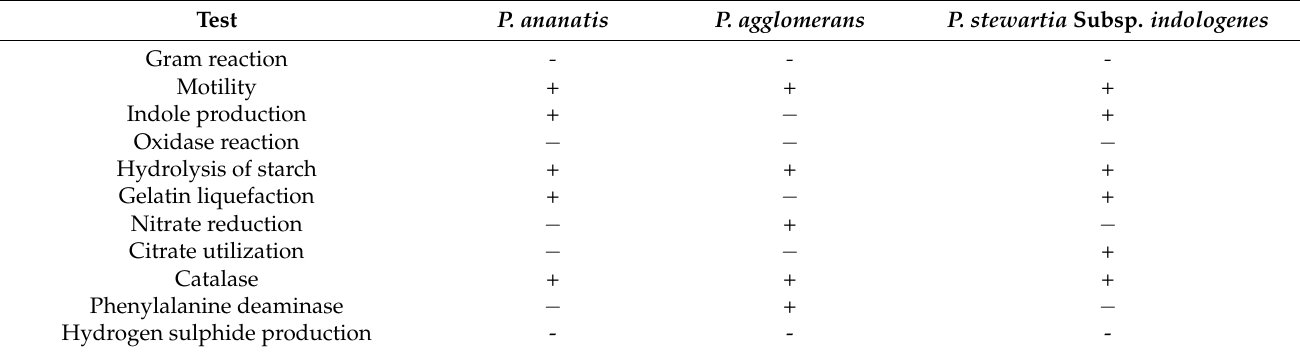
Table 5. Biochemical tests of Pantoea species associated with rice